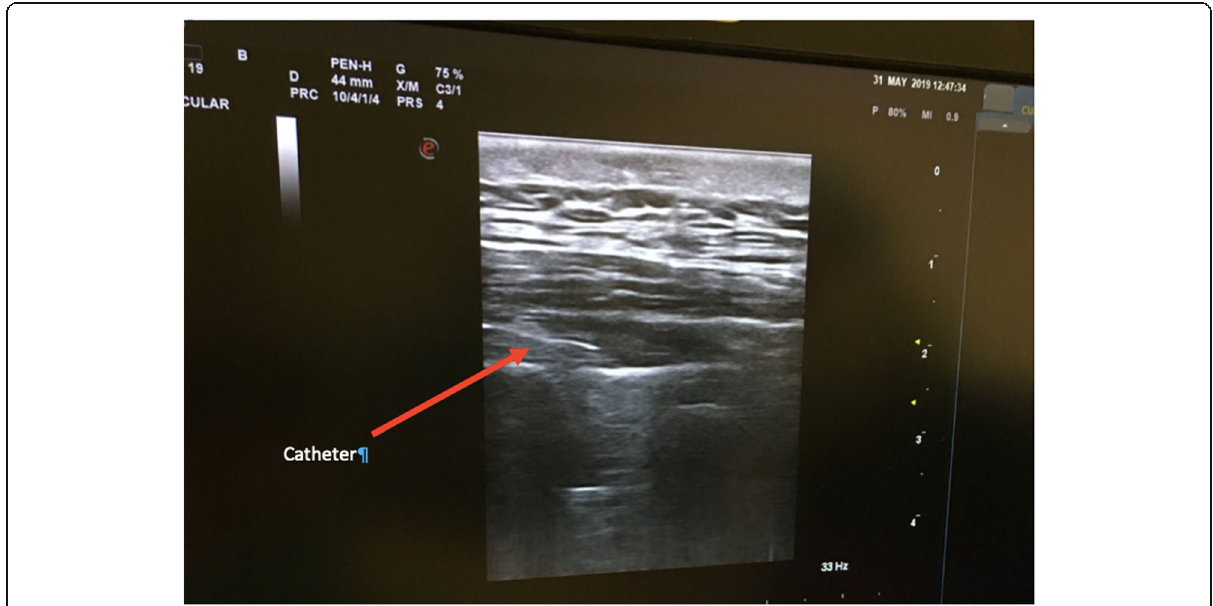
Fig. 2 Advancing of catheter in the erector spinae plane